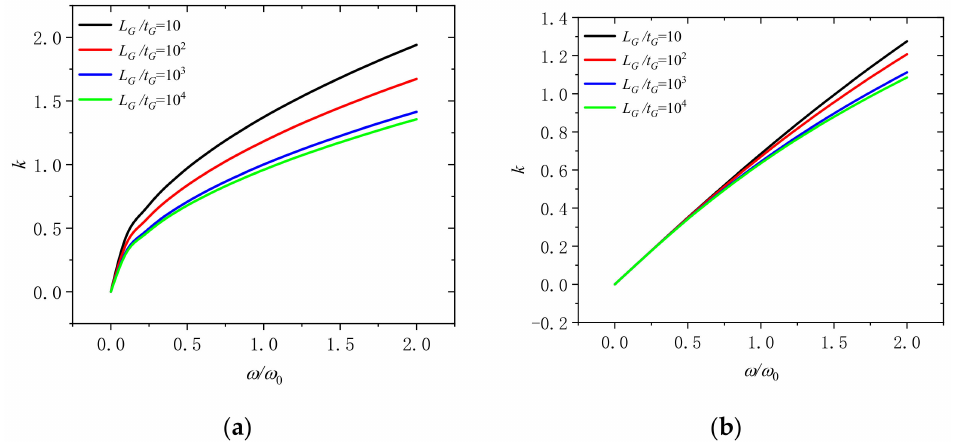
Figure 5. Wavenumber dispersion in a rotating microbeam with different length thickness ratio of GPLs ( L G / t G = 10, 10 2 , 10 3 , and 10 4 ) for ( a ) Ω / Ω 0 = 0 and ( b ) Ω / Ω 0 =